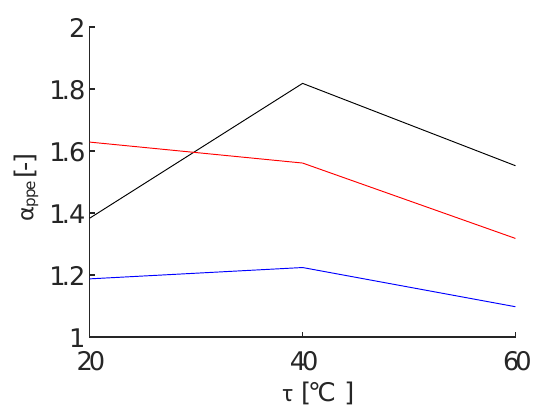
Figure 21: α ppe as a function of temperature for all three oil types. HV(black),